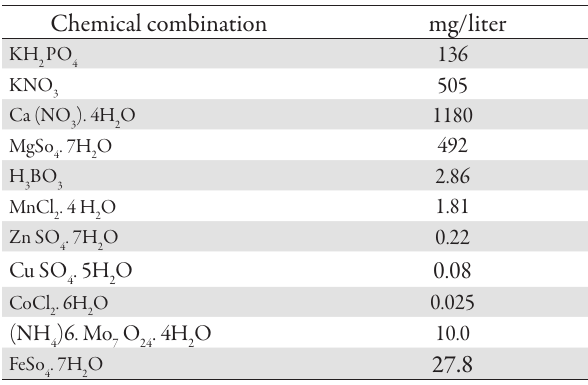
Tab. 1. Element composition of nutrient solution were used in